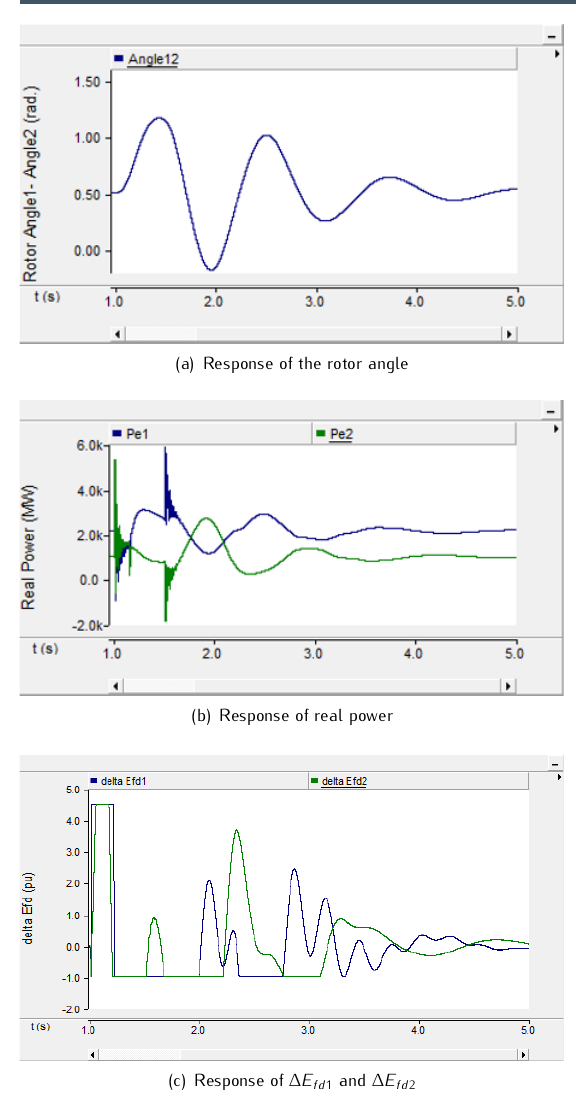
Figure 7 A three-phase fault happened at point f under H-infinity control Figure 7. A three-phase fault happened at point f under H-infinity